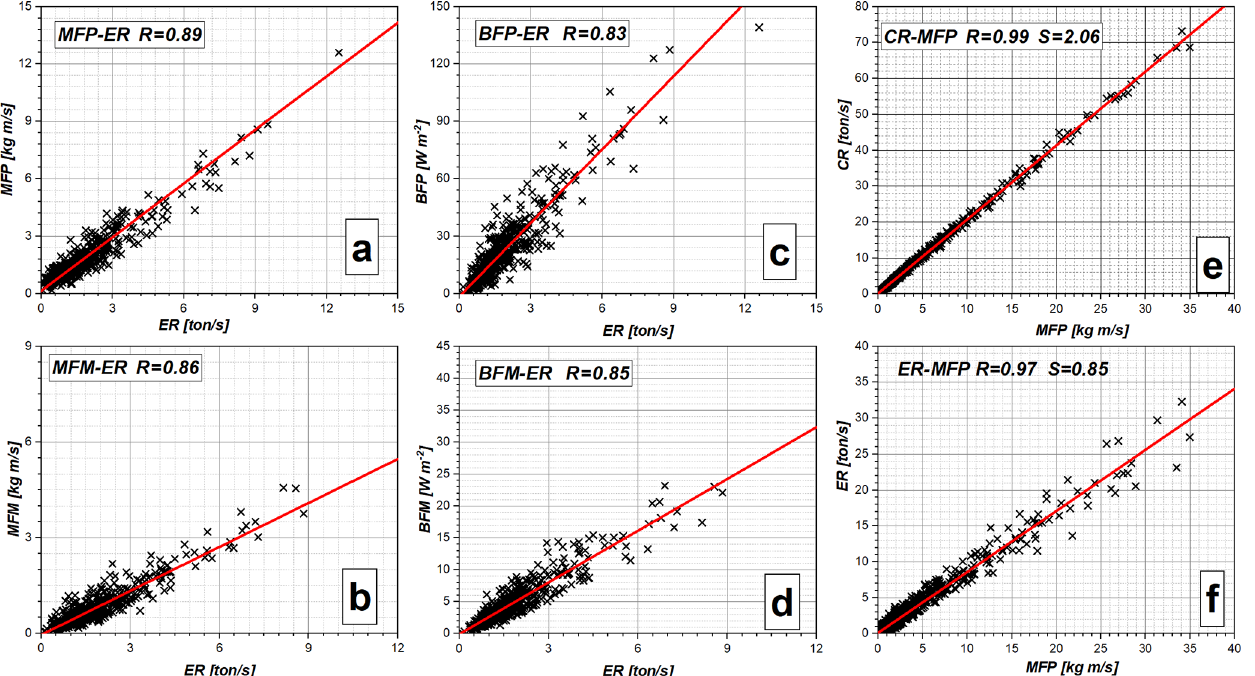
Figure 3. Correlation plots of: (a–d) ER with mass and buoyancy flux for G2 clouds, (e–f) – CR/ER with upward mass flux MFP for clouds from all groups combined . R is the correlation coefficient, S is the slope of the linear fit shown by the red line.